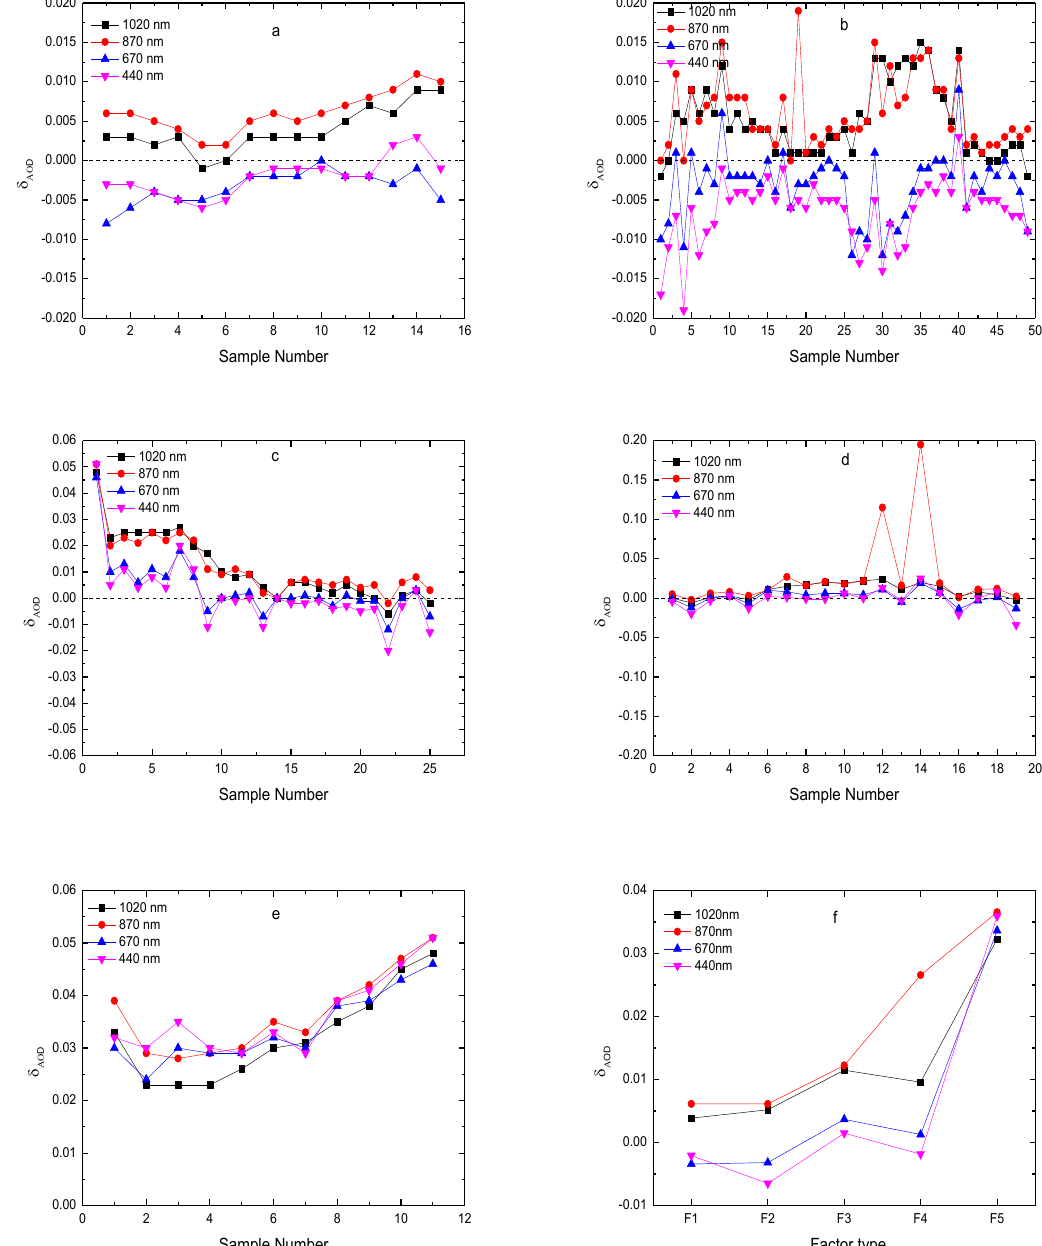
Figure 6. Simultaneously measured AOD differences between the reference instrument and the experiment instruments under the effects of five factors: ( a ) spider web inside the collimator, ( b ) collimator bending, ( c ) dust inside the optical head, ( d ) incrustation scale inside the optical head, and ( e ) dust and incrustation scale inside the optical head and ( f ) the averaged AOD differences under the effects of five factors.